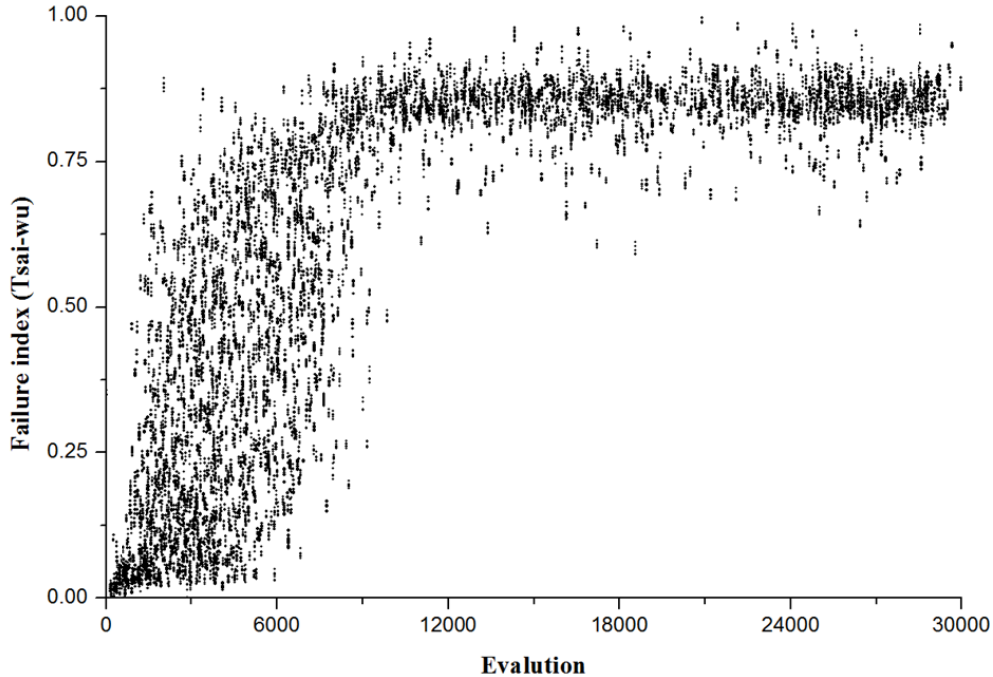
Figure 10. Optimization result, failure index (Tsai-wu).